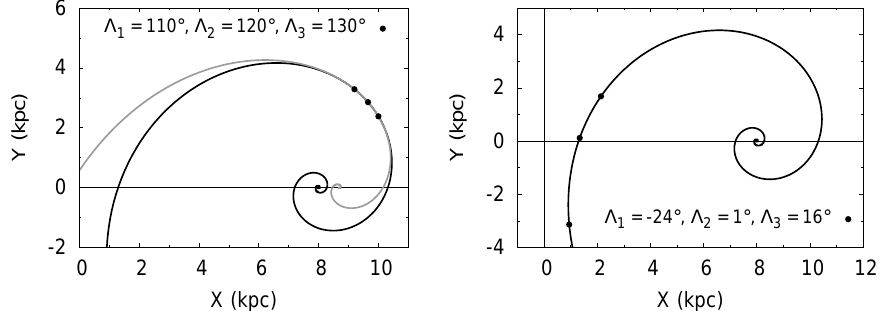
Fig. 1. Spirals passing through the three given points. The black line shows the model spiral. The gray line (left panel) shows the second spiral which passes through the given points in the case if they are located on the same side of the X -axis.